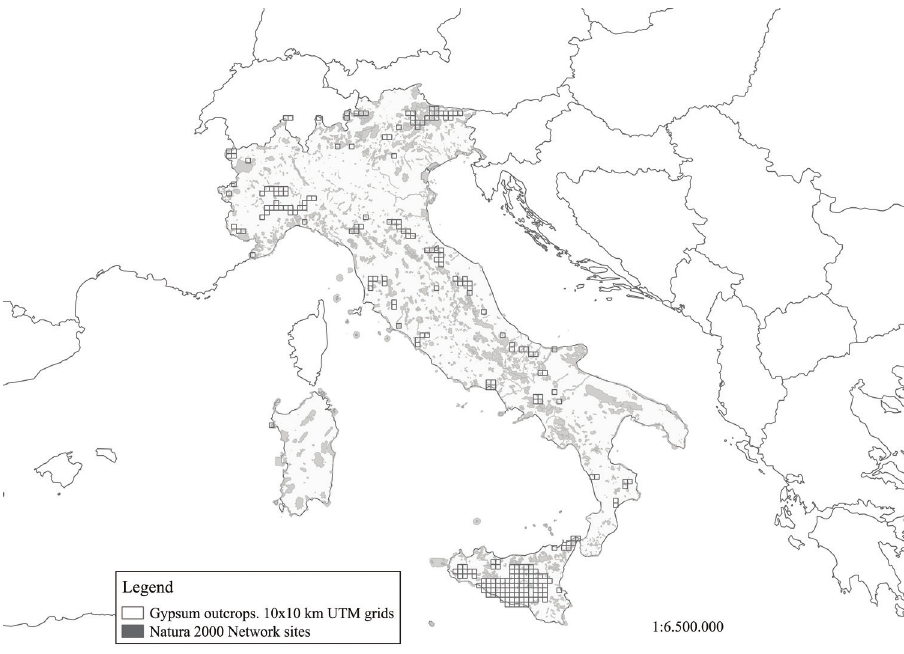
Figure 1. Italian gypsum outcrop presences in 10×10 km UTM grids.